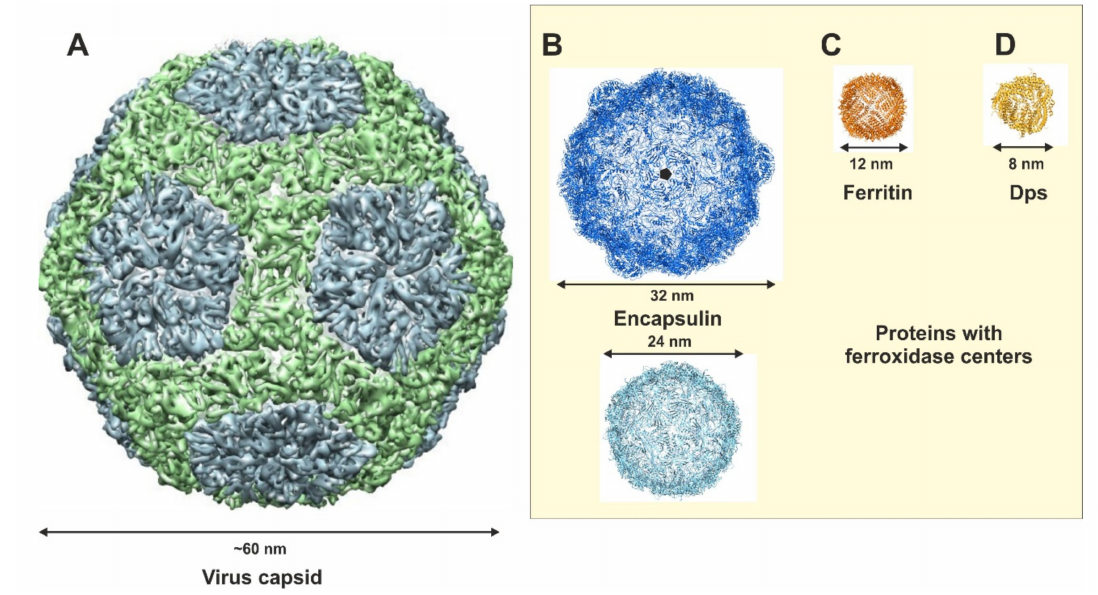
Figure 1. Structures of CSPs used as biocompartments represented as surface or ribbon models. ( A ) Bacteriophage P22 viral capsids shown in surface representation. ( B ) Encapsulin from Myxococcus xanthus (upper) and from Themotoga maritima (lower) shown in cartoon representation with the individual dimensions given. ( C ) Ferritin consisting of 24 identical subunits and an outer diameter of 12 nm. ( D ) Dps protein complex consisting of 12 identical subunits and an outer diameter of 8